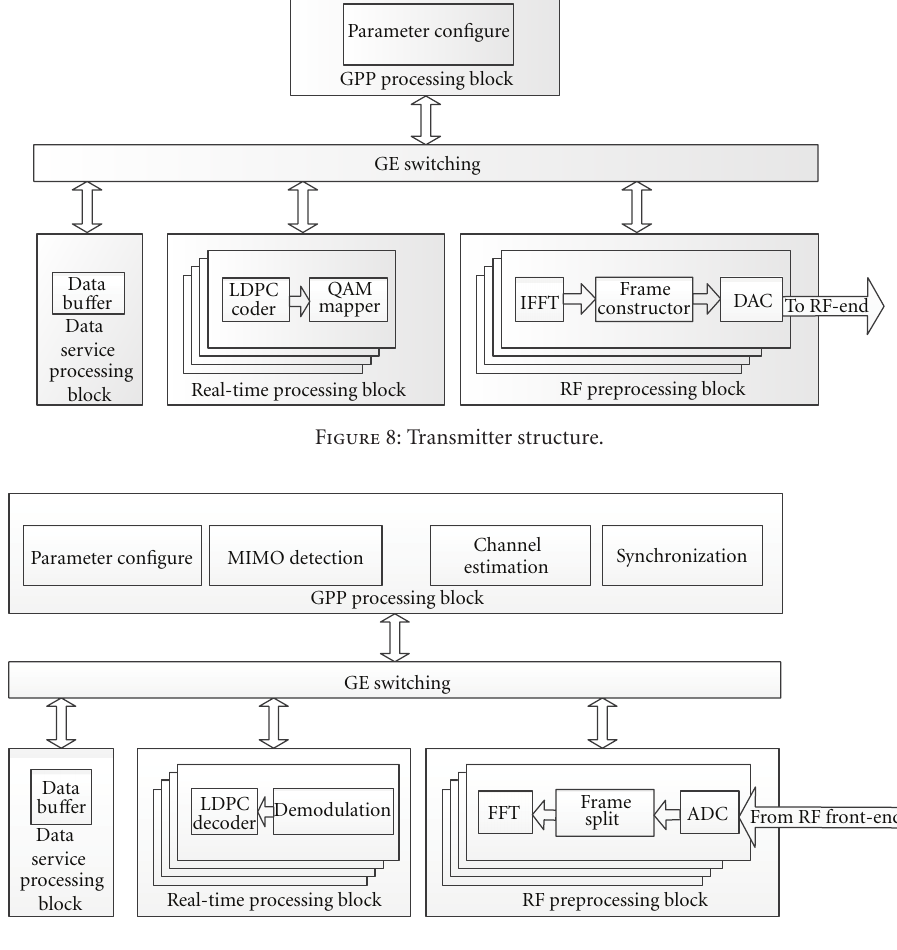
Figure 9: Receiver structure.